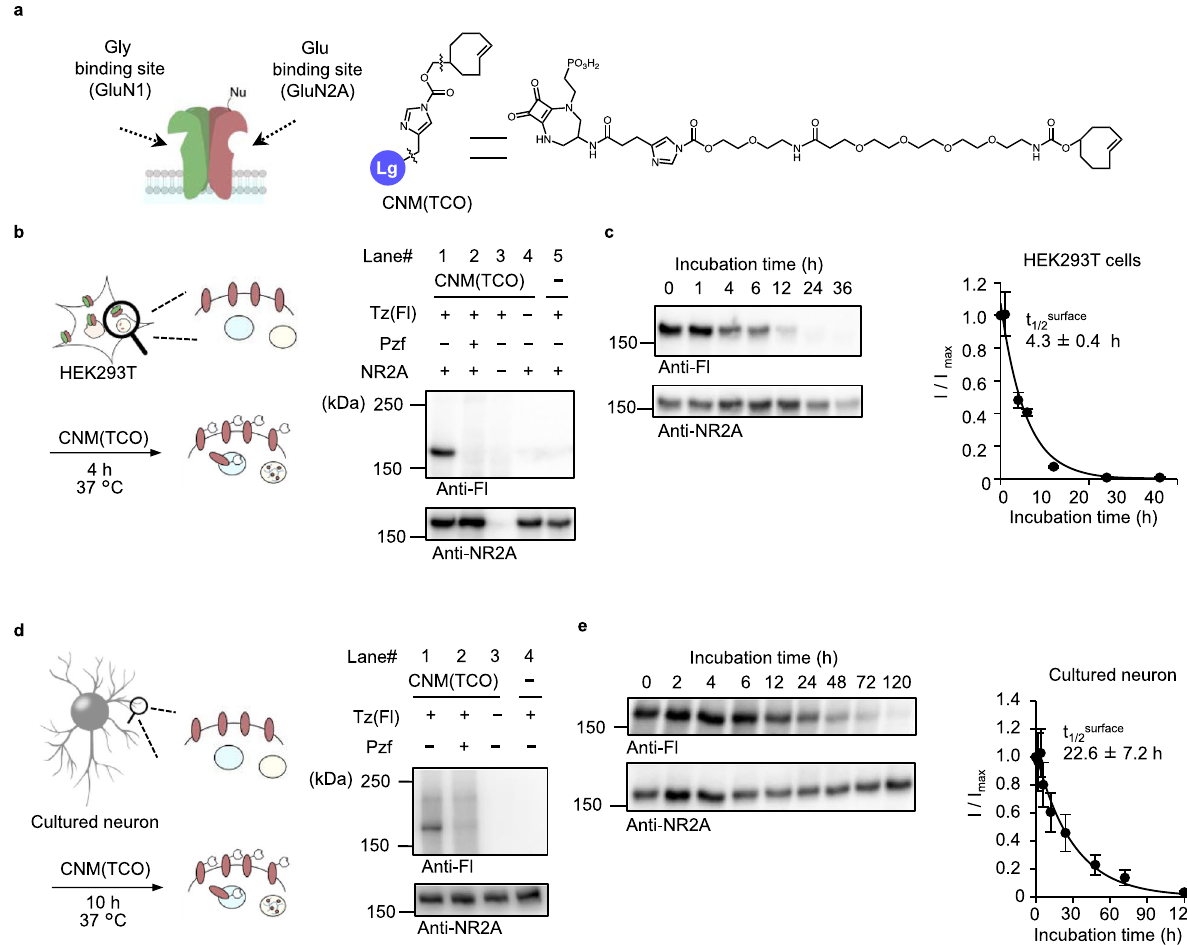
Fig. 6 The two-step labeling of cell-surface NMDARs in HEK293T cells and neurons. a Chemical structure of CNM(TCO) for two-step labeling reagent for NMDARs. Gly glycine. b Two-step labeling of cell-surface NMDARs ectopically expressed in HEK293T cells. In left, schematic illustration is shown. In right, western blotting analyses after the two-step labeling are shown. HEK293T cells transfected with NR1-1 and NR2A or vector control were treated with 10 μ M CNM(TCO) for 4 h followed by the addition of 1 μ M Tz(Fl) for 5 min in the presence or absence of 250 μ M Pzf in culture medium at 37°C. The cell lysates were analyzed by western blotting using anti- fl uorescein or anti-NR2A antibody. c Determination of t 1/2 surface of NMDARs in HEK293T cells by western blotting. In left, representative results of western blotting are shown. In right, time-course of the labeled band is shown ( n = 3 biological replicates). d Two-step labeling of cell-surface NMDARs endogenously expressed in cultured cortical neurons. In left, schematic illustration is shown. In right, western blotting analyses after the two-step labeling are shown. The cultured cortical neurons were treated with 10 μ M CNM(TCO) for 10 h followed by the addition of 1 μ M Tz(Fl) for 5 min in the presence or absence of 250 μ M Pzf in culture medium at 37°C. The cell lysates were analyzed by western blotting using anti- fl uorescein or anti-NR2A antibody. e Determination of t surface of NMDARs in neurons by western blotting. In left, representative results of western blotting 1/2 are shown. In right, time – course of the labeled band is shown ( n = 3 biological replicates). Data are represented as mean ±